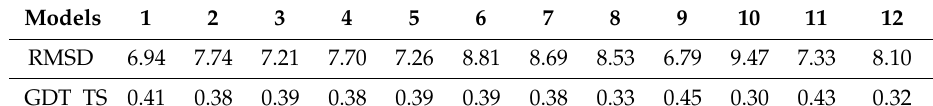
Table 3. The CABS-flex results of the p-tau protein simulated models table containing RMSD and GDT_TS values (calculated on the C α atoms) between the predicted models. Model 1 had the least RMSD with 6.94 and was considered the best model for further docking analysis.